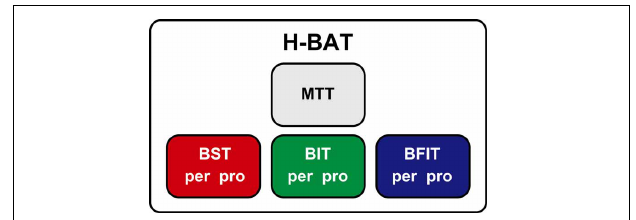
FIGURE 1 | A schematics of the Harvard Beat Assessment Test (H-BAT). H-BAT consists of four subtests; music tapping test (MTT), beat saliency test (BST), beat interval test (BIT), and beat finding and interval test (BFIT). The BST, BIT, and BFIT have a perception (per) and production (pro) part